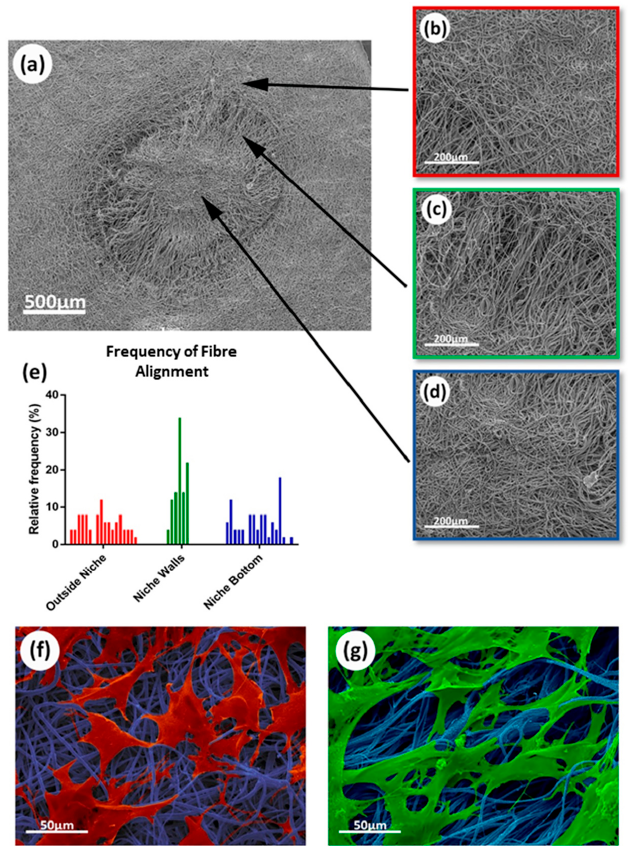
Figure 4. SEM analysis of electrospun scaffolds fibers and alignment impact on cell morphology: ( a ) SEM micrograph of synthetic niche in electrospun scaffold; ( b – d ) SEM images showing different sections of fibers within the niche, specifically: ( b ) Randomly aligned fiber area outside niche; ( c ) aligned fibers in the niche wall; ( d ) randomly aligned fiber area at the bottom of the niche; ( e ) analysis of the fiber alignment within the different sections of the niche presented as a histogram; ( f ) morphology of rMSCs growing on more random fibers; ( g ) morphology of rMSCs growing on more aligned fibers.